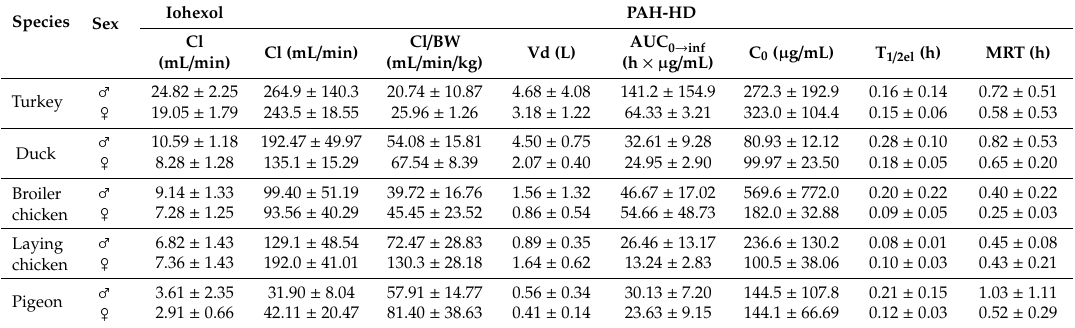
plasma concentration at time 0; T 1 / 2el , the elimination half-life; MRT, mean residence time. Table 2. Main pharmacokinetic parameters of para-aminohippuric acid and iohexol clearance following the IV administration of 100 mg para-aminohippuric acid and 64.7 mg iohexol / kg BW to di ff erent poultry species. Values ( n = 8) are presented as mean ±